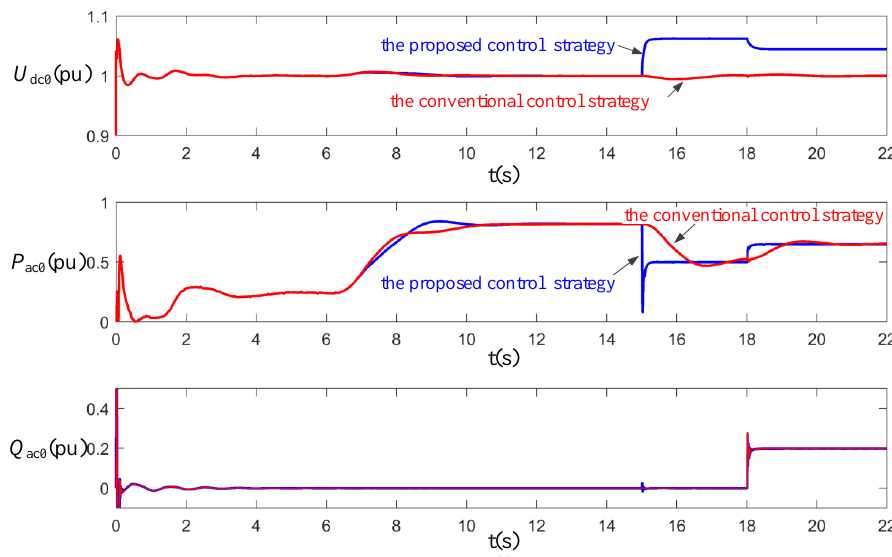
Figure 17. Comparison of the two control strategies.